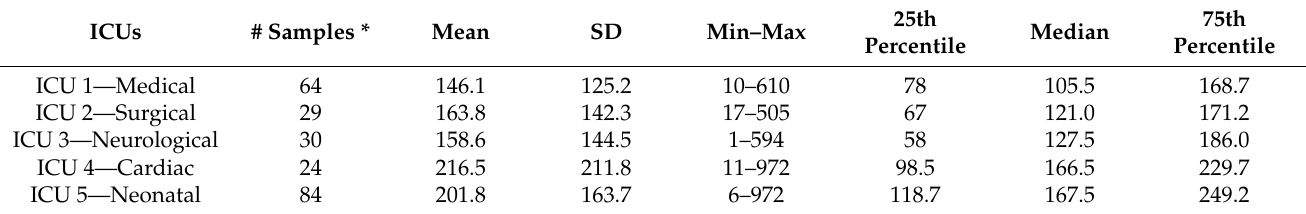
Table 2. Number of air samples and bacterial contamination (CFU/m 3 ) in each ICUs. (#: number).